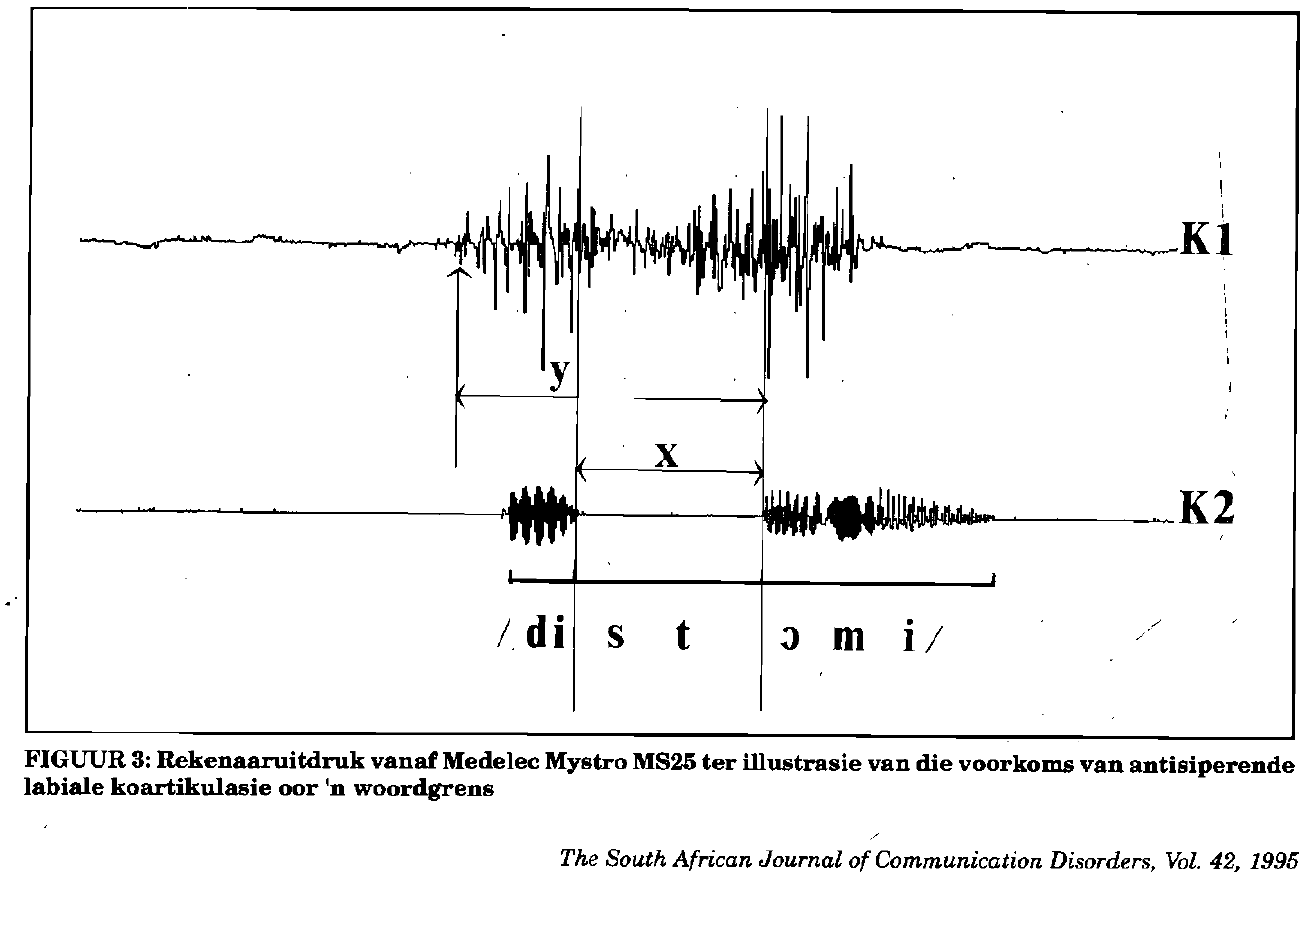
FIGUUR 3: Rekenaaruitdruk vanaf Medelec Mystro MS25 ter illustrasie van die voorkoms van antisiperende labiale koartikulasie oor 'n